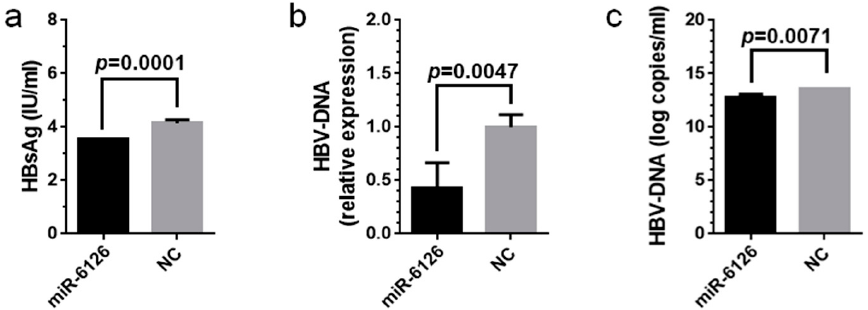
Figure 5. Antiviral activity of miR-6126 in vitro. ( a ) Transfection of miR-6126 mimic into Huh7/sodium taurocholate cotransporting polypeptide (NTCP) cells significantly reduced HBsAg levels in culture medium supernatants ( p < 0.05); ( b , c ) Transfection of miR-6126 mimic into Huh7/NTCP cells significantly reduced intracellular HBV-DNA quantities ( b ) and HBV-DNA levels in culture medium supernatants ( c ) compared with the negative control (NC) mimic ( p < 0.05). In the experiment ( a ), cells were passaged on day 0; miR-6126 mimic or NC mimic was transfected on day 1; cells were infected with HBV on day 2; and culture medium supernatants were harvested on day 5. In the experiments ( b , c ), cells were passaged on day 0; miR-6126 mimic or NC mimic was transfected into cells on day 1; cells were infected with HBV on day 2; and miR-6126 mimic or NC mimic was added to cells again on days 3, 5 and 7. Intracellular DNA and culture medium supernatants were harvested on day 9. Intracellular HBV-DNA quantities were normalized to those of GAPDH, an internal control. All the experiments ( a – c ) were performed three times with four replicates and analyzed with Student’s t -tests, then the representative data were plotted with the mean and SD.